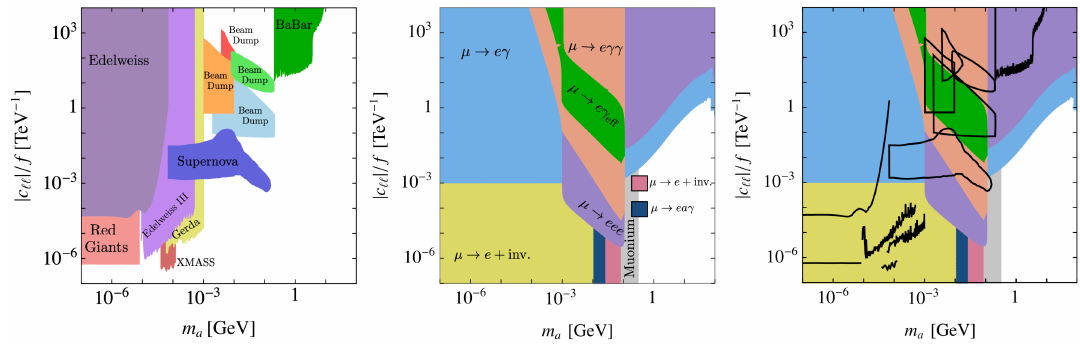
Figure 42 . Left: astrophysical, beam dump, and collider constraints on ALP couplings to leptons c ‘‘ = c e − c L (as in figure 28). Center: bounds on ALP mediated flavor off-diagonal µ → e transition with a fixed value of the lepton flavor off-diagonal coupling c 1 TeV − 1 as a function of the universal ALP coupling to leptons, c ALP mass, m . All other Wilson coefficients are set to zero at tree-level. Right: overlay of the flavor a constraints (shown in the central panel) in color and the astrophysical, beam dump and collider limits (shown in the left panel) depicted by black contour